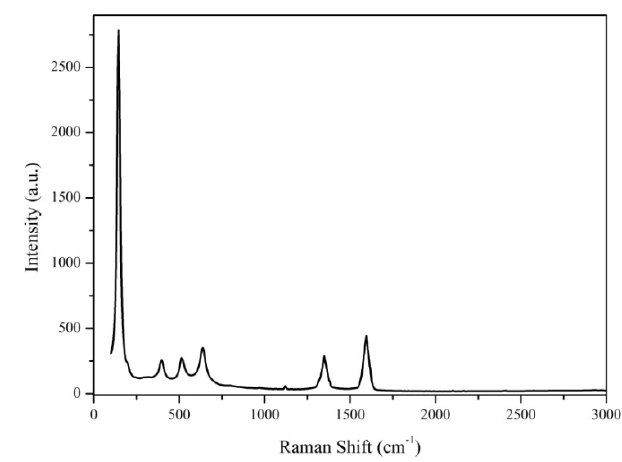
Figure 2. Raman spectra of MWCNTs_TiO